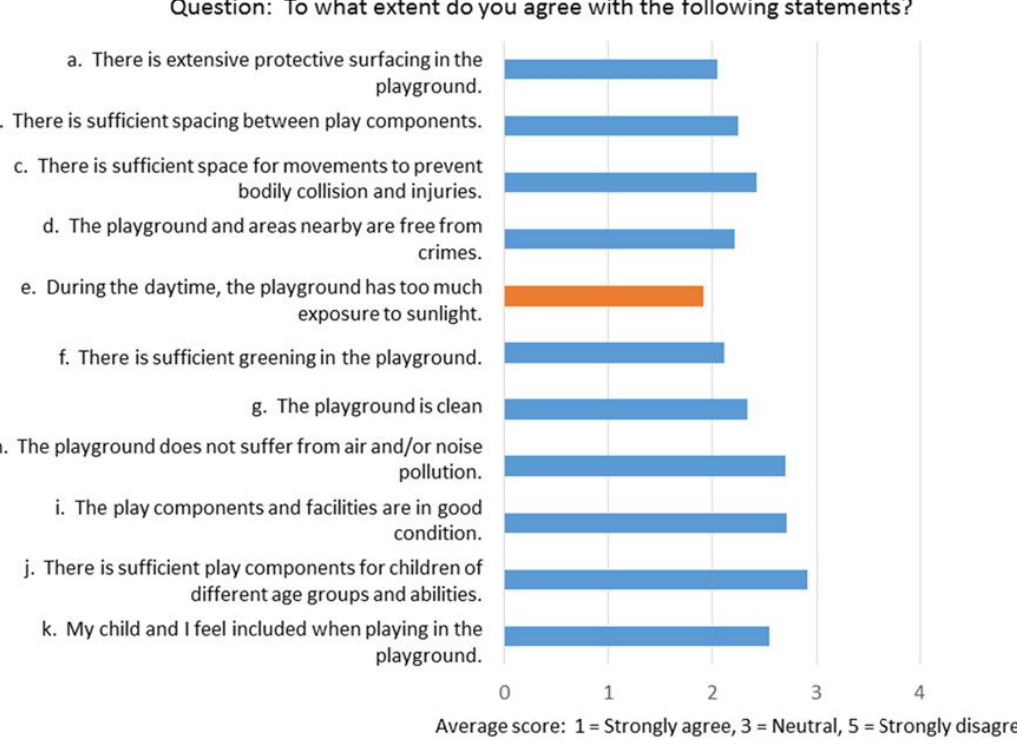
Figure 2. Perception of parents toward playgrounds in their respective neighborhoods.